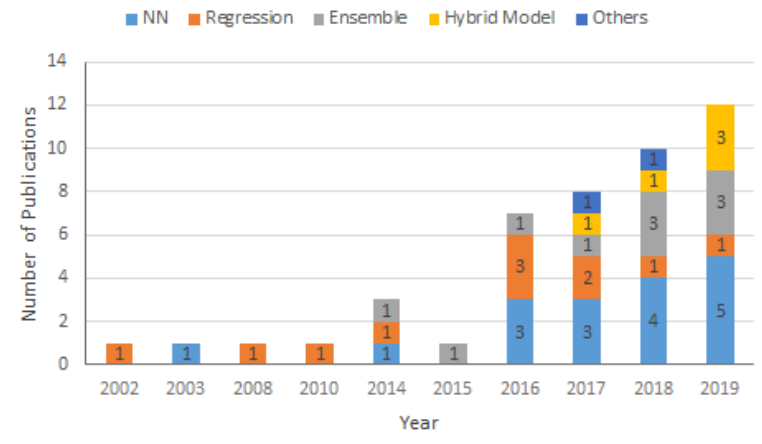
Figure 5. Number of publications per machine learning algorithms throughout the